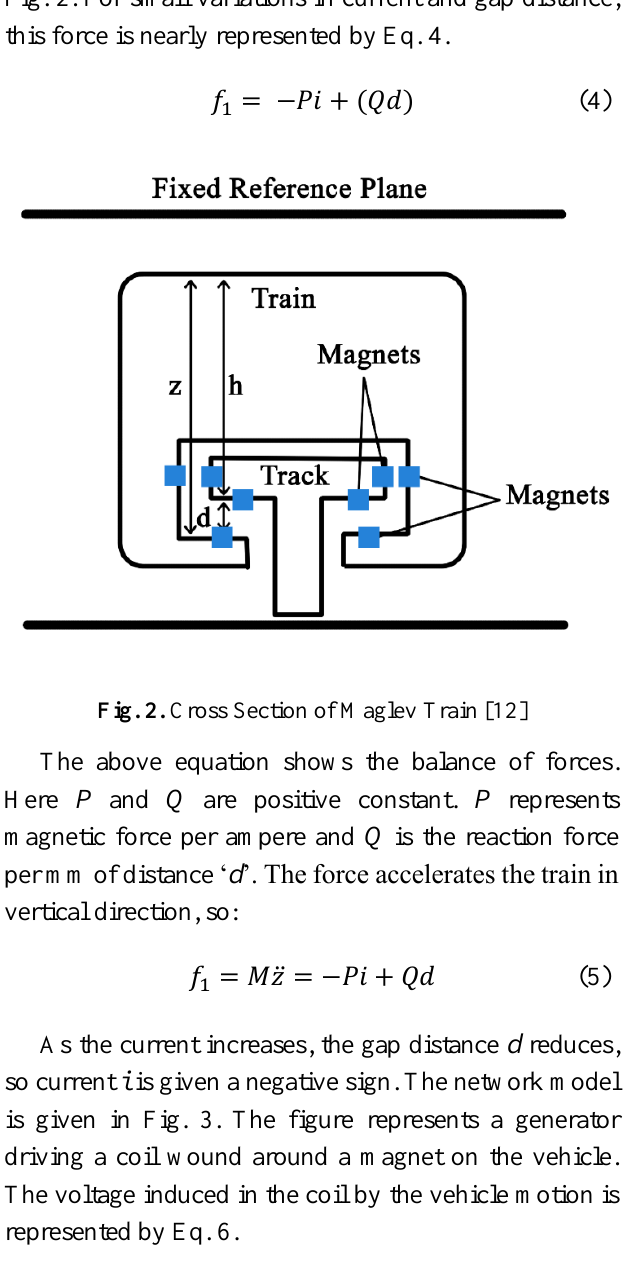
Fig. 2. For small variations in current and gap distance, this force is nearly represented by Eq. 4.